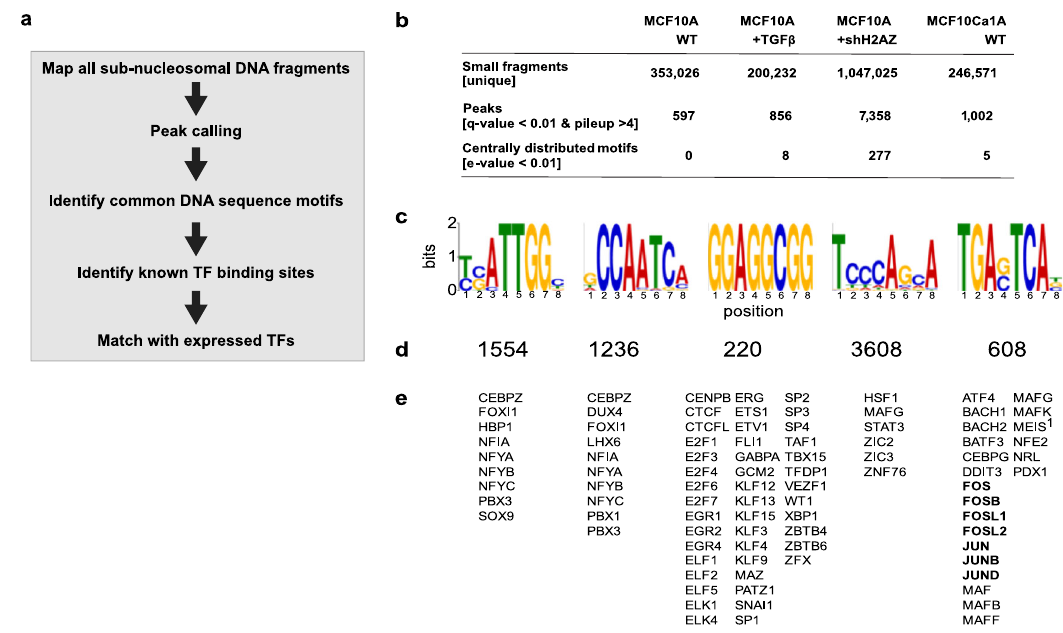
Fig. 7 Loss of H2A.Z causes a dramatic increase in subnucleosomal-sized DNA fragments that map to transcription factor binding sites. a Summary of the analysis. b Subnucleosomal-sized DNA fragments from all reads were extracted and aligned to all promoter regions and peak-calling was performed to detect enriched DNA sequence motifs within ±250 bp of the peak centres. c The top fi ve DNA binding motifs that correspond to transcription factors expressed in the shH2A.Z MCF-10A cells. d The corresponding number of promoter sites at which each of these top fi ve motifs were found in shH2A.Z MCF-10A cells. e The 93 transcription factors expressed, which recognise each of the top fi ve DNA binding motifs in shH2A.Z MCF-10A cells. Highlighted in bold are important EMT transcription factors whose DNA recognition motif overlaps with subnucleosomal peaks that were previously occupied by H2A. Z